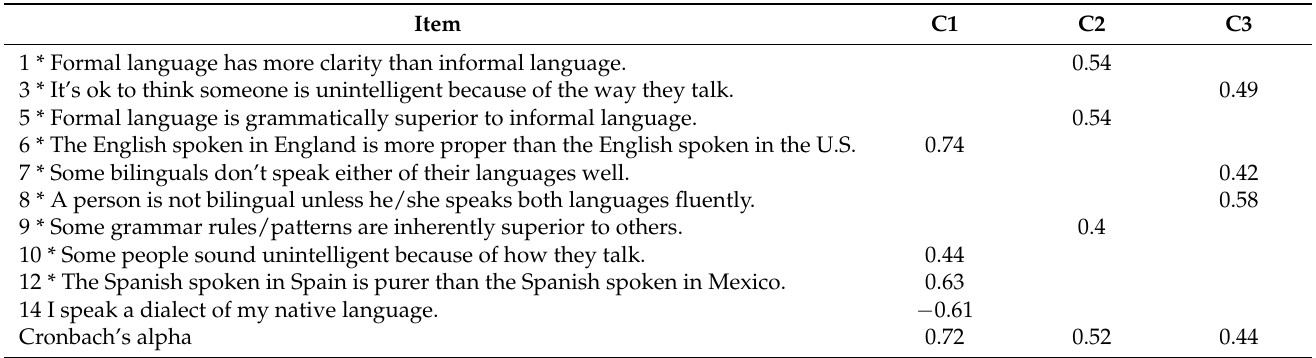
Table 5. Factor loadings of the 10 items on the three factors by exploratory factor analysis and interitem reliability of each factor as measured by Cronbach’s